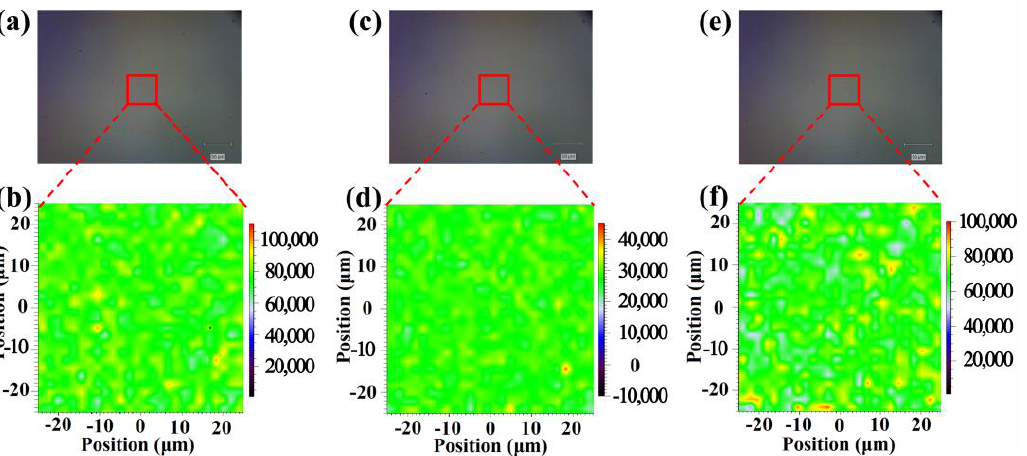
Figure 3. The video and Raman images of cured EP/EHBFR-HB30 ( a , b ), cured EP/EHBFR-HCM30 ( c , d ), and cured EP/EHBFR-HBM30 ( e , f ).